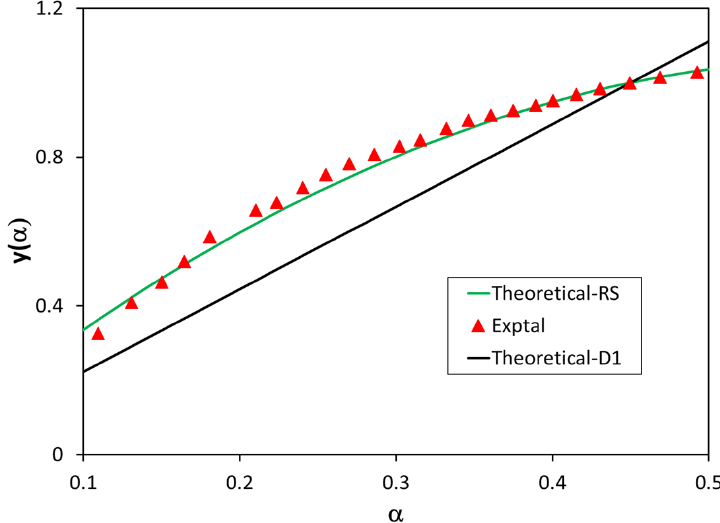
Figure 8. Comparison between experimental and theoretical values of y ( α ) master plots for random scission (RS) and D1 mechanisms for the bioblend containing 90% PLA.